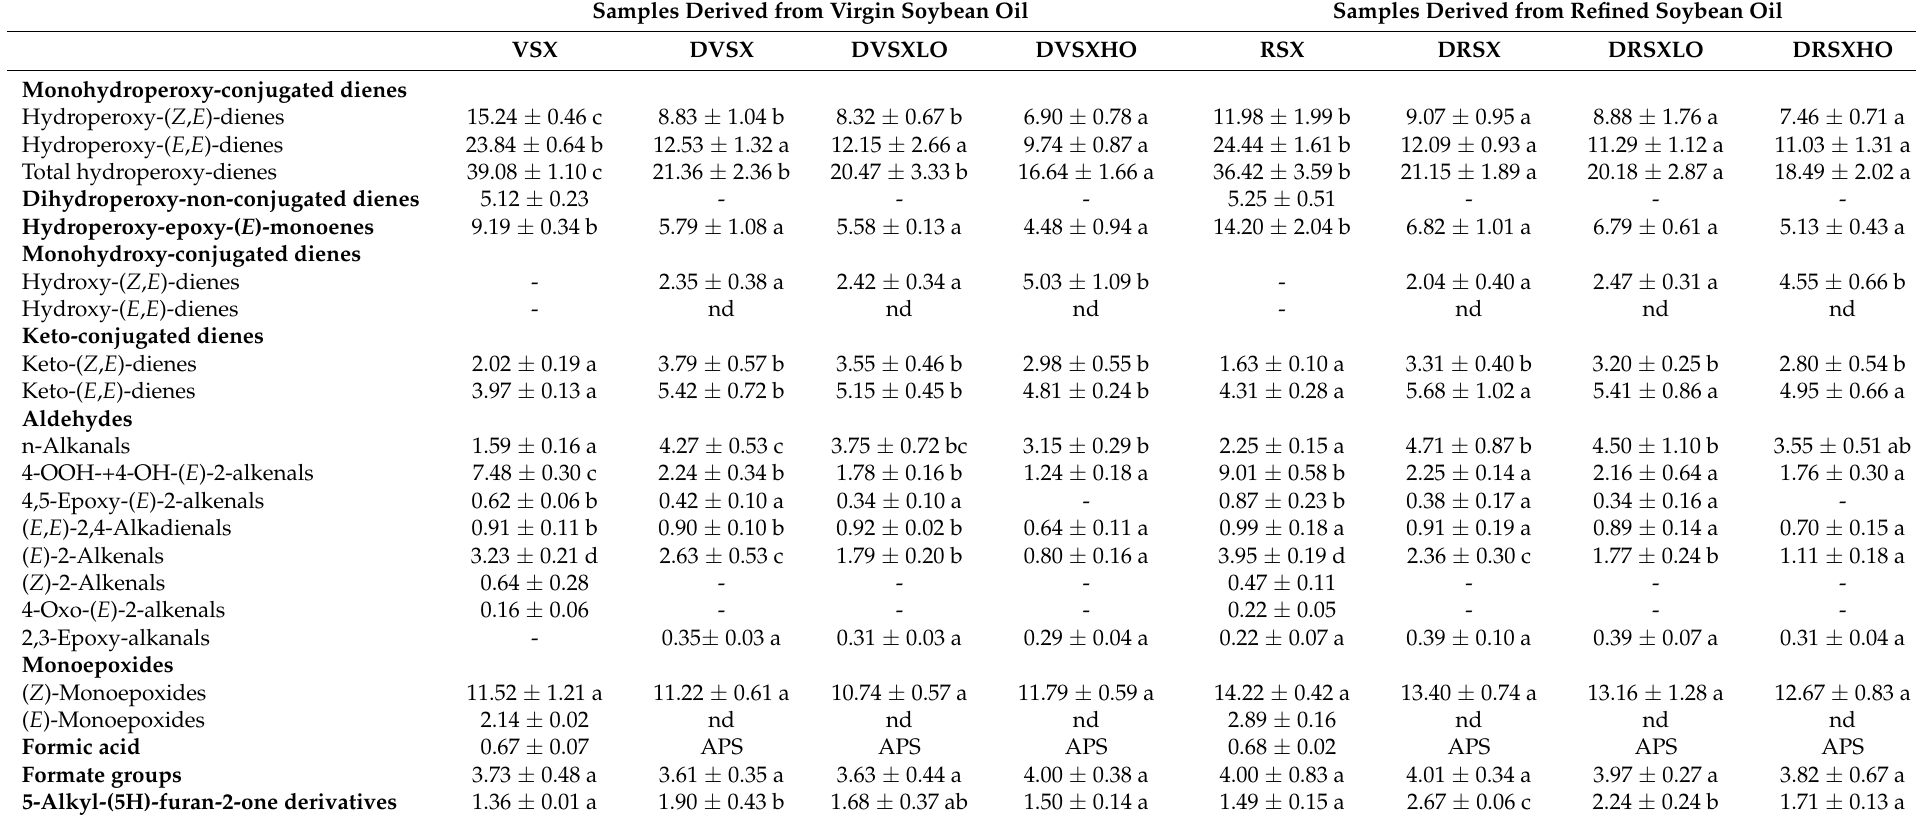
Table 3. Concentrations of the several kinds of oxidation structures and compounds, expressed in mmol/mol acyl groups+fatty acids, present in the oxidized virgin and refined soybean oil samples (VSX and RSX) and in their digestates (DVSX and DRSX), as well as in the digestates of VSX and RSX samples mixed with two different levels of ovalbumin: 26% in weight (DVSXLO and DRSXLO) and 260% in weight (DVSXHO and DRSXHO). Different letters within each row indicate a significant difference among the samples corresponding to the